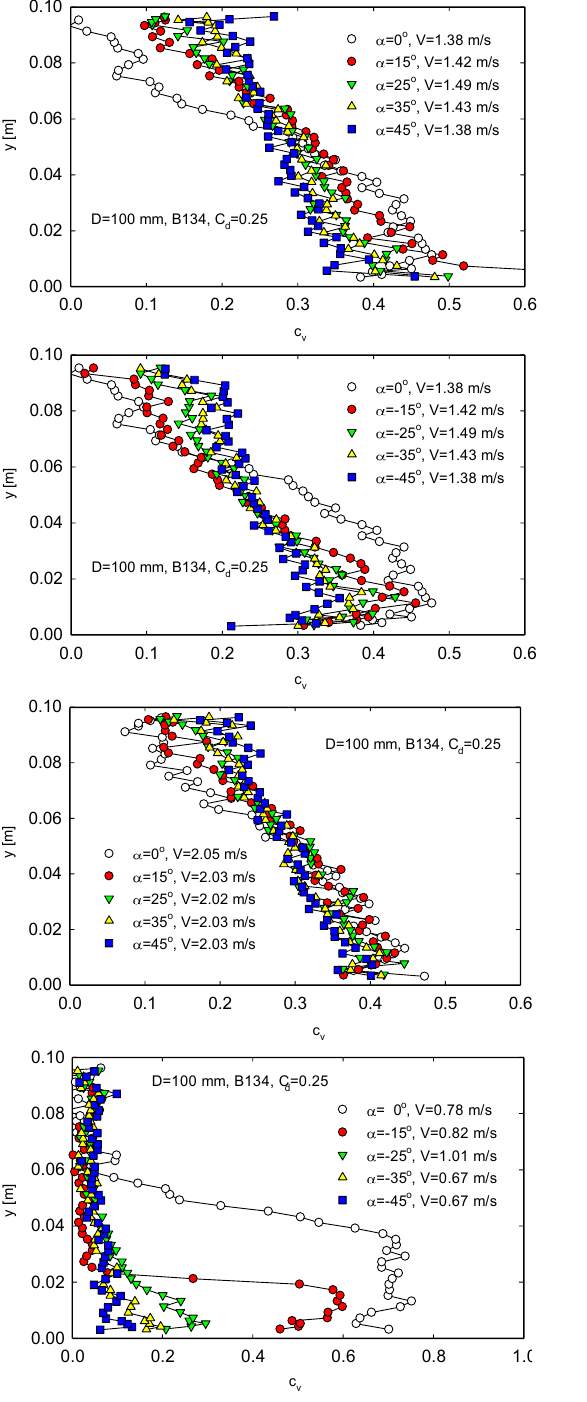
Fig. 5. Effect of the pipe inclination α ( C d = 0.25).